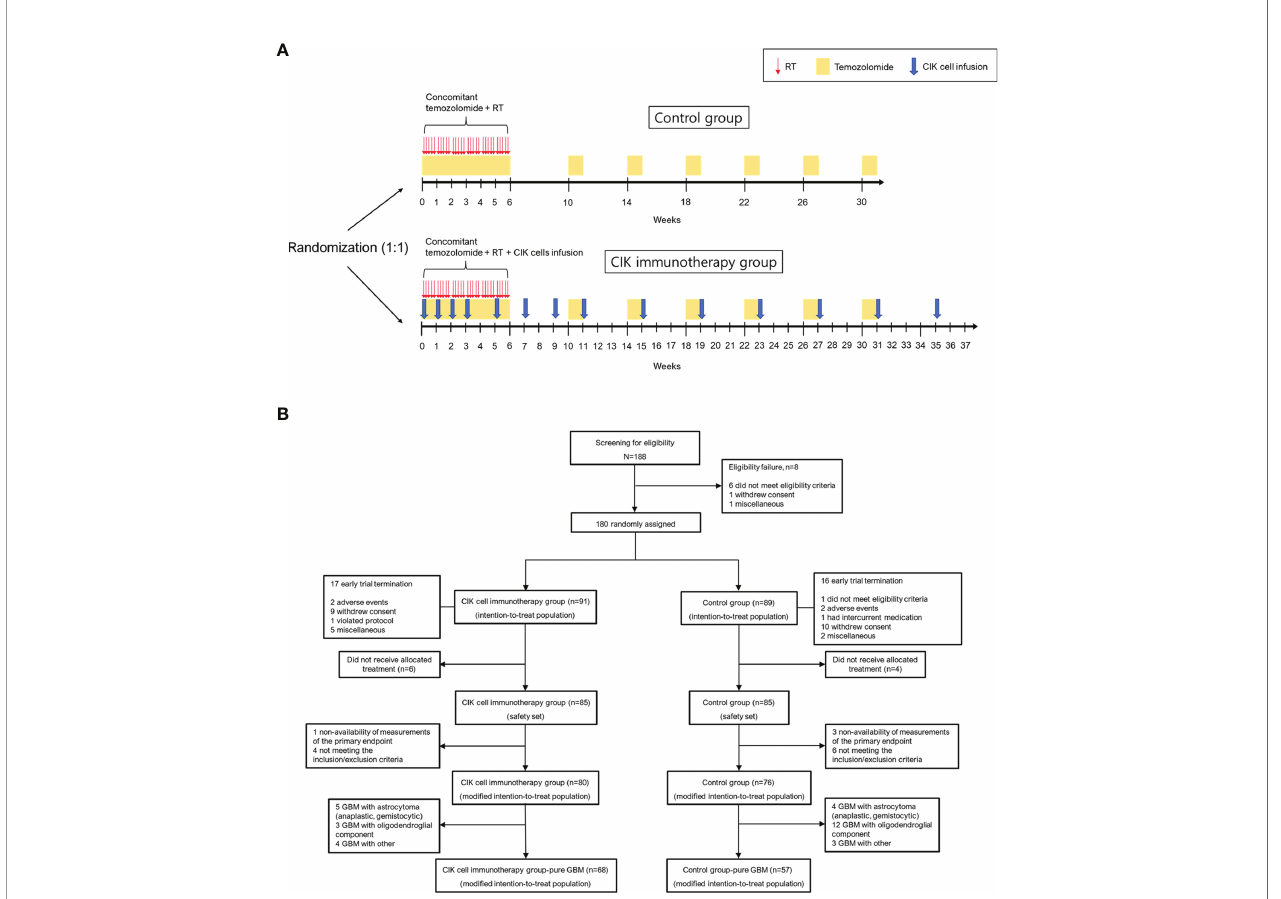
FIGURE 1 | Overall study protocol. (A) Schematic overview of the trial. (B) Patient disposition. CIK, cytokine-induced